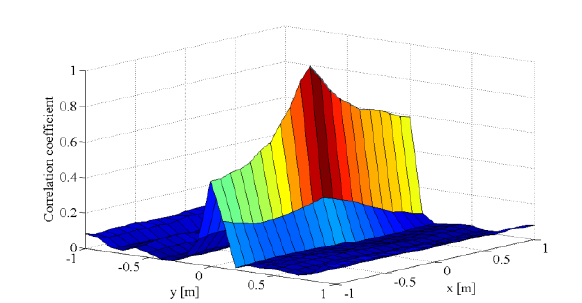
Figure 9. Correlation plot in a range of 2 m x 2 m with a resolution of 0.10